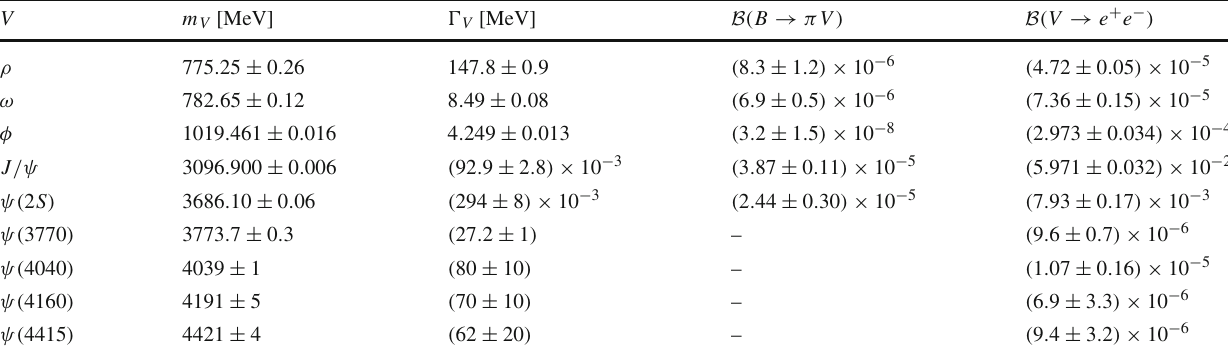
Table 1 Experimental inputs for the determination of resonance contributions in B → π(cid:3) + (cid:3) − , from Ref. [52]